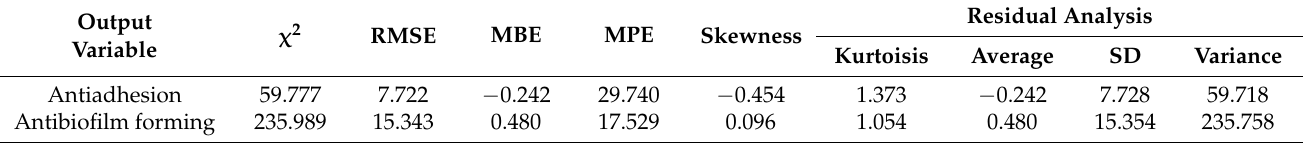
Table 3. The “goodness of fit” tests for the developed ANN